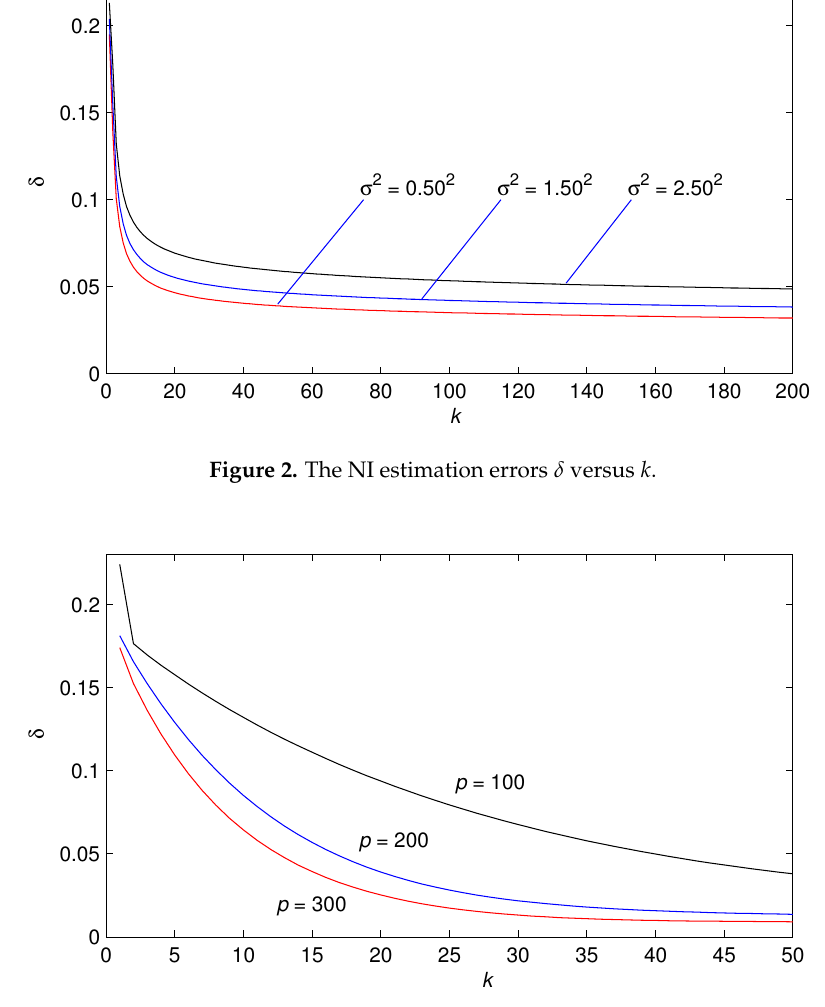
Figure 3. The MDW-GI estimation errors δ versus k ( σ 2 = 0.50 2